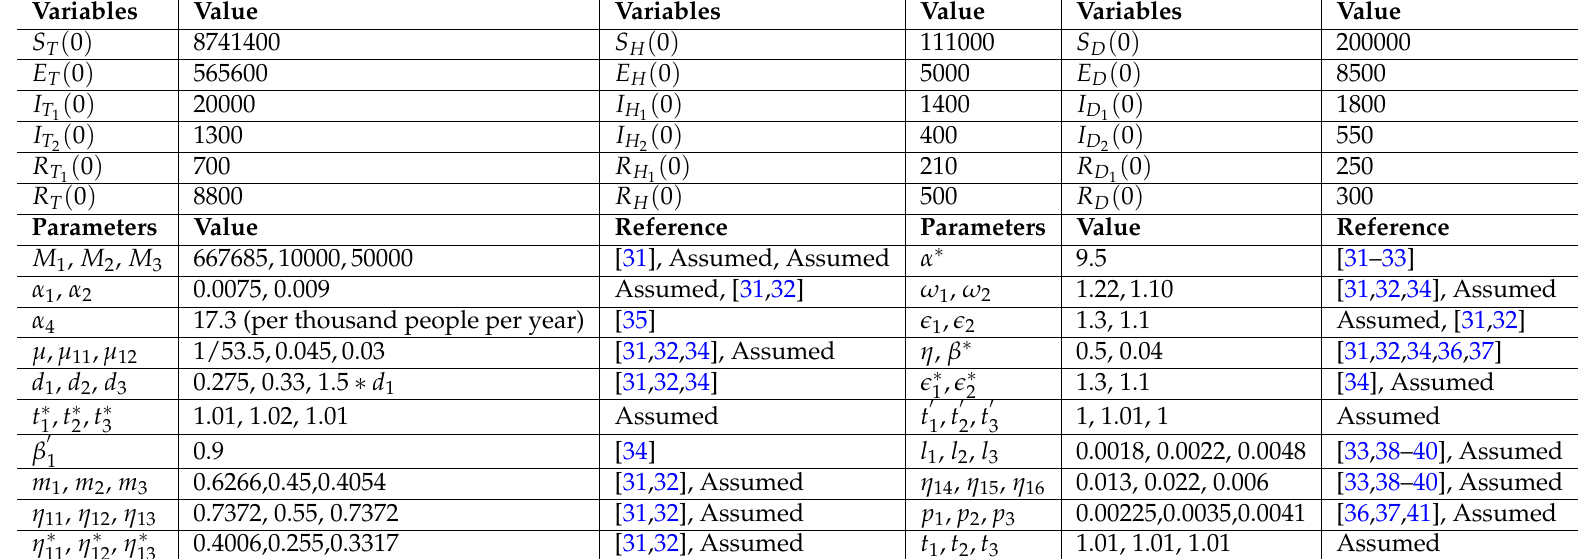
Table 2. Values of variables and parameters used in the model